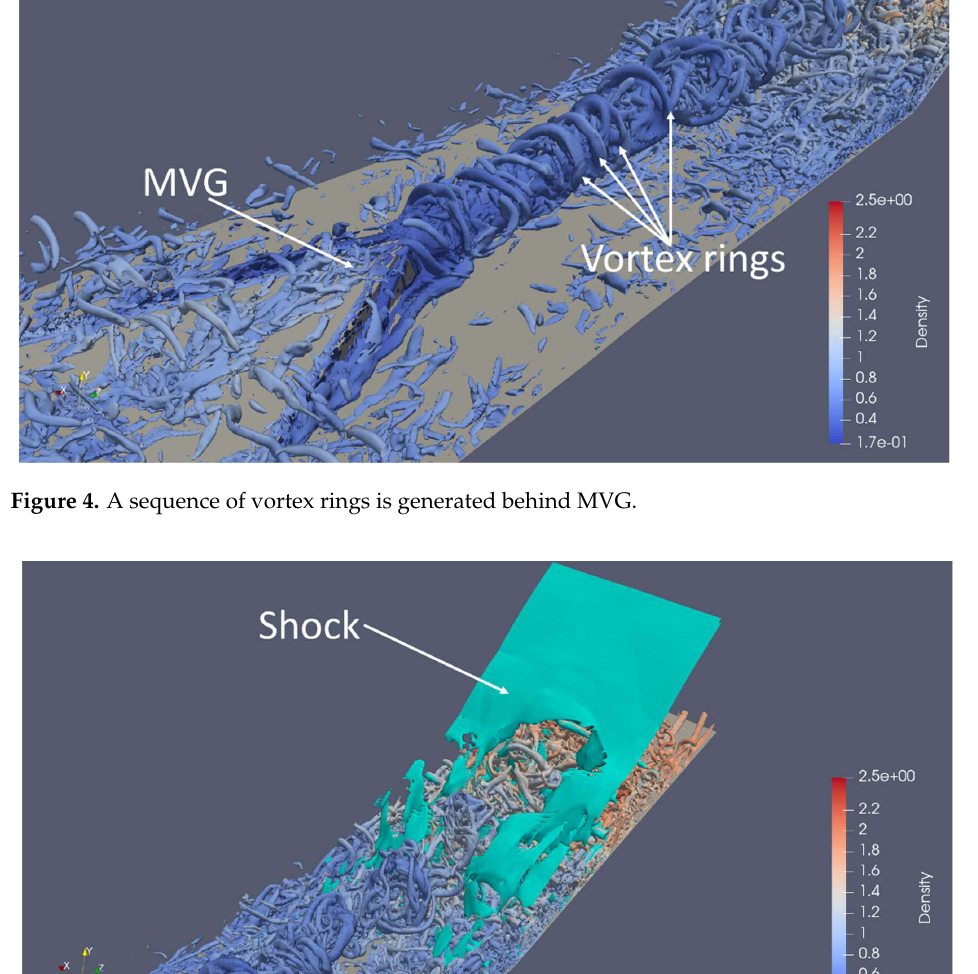
Figure 6. In time-average view, the reduced flow separation due to the vortex rings is generated by MVG. 4.2. Impact of the Minor Changes of Distance between MVG and Ramp Corner on SWBLI Separation Figure 7 shows the vortex structures in the four cases of this study. Liutex iso-surface ( ‖𝑹‖ = 0.3 ), contoured by streamwise velocity magnitude, was used to illustrate the vor- tex structures. It can be found that, with different distances between MVG and ramp cor- ner, the large-scale ring-like vortices in these four cases are quite similar, especially in the size, topology, and frequency.